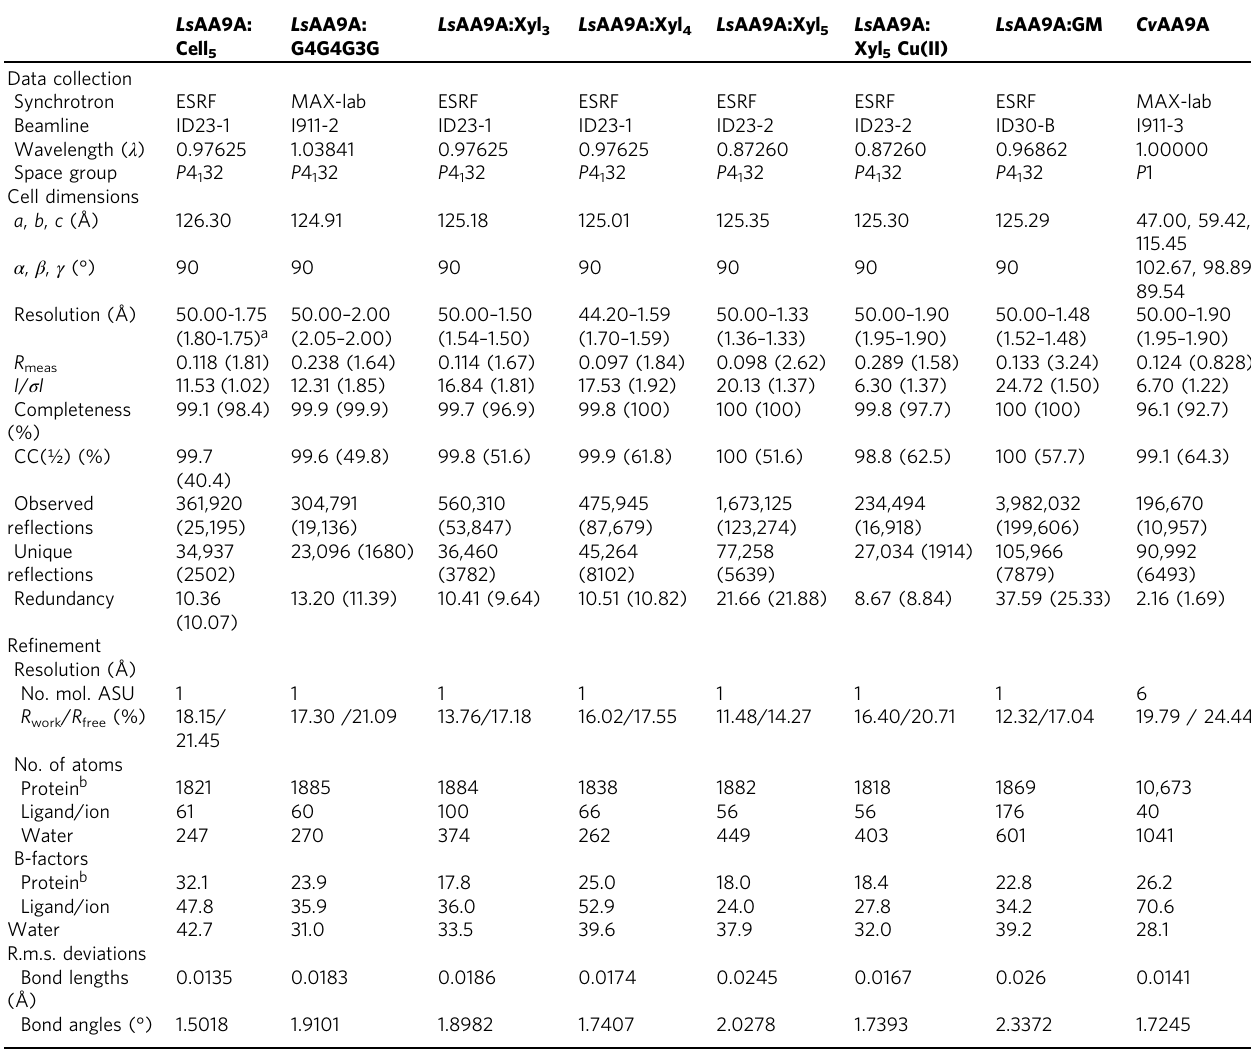
Table 2 Scaled crystallographic data statistics and re fi nement statistics Ls AA9A: Cell